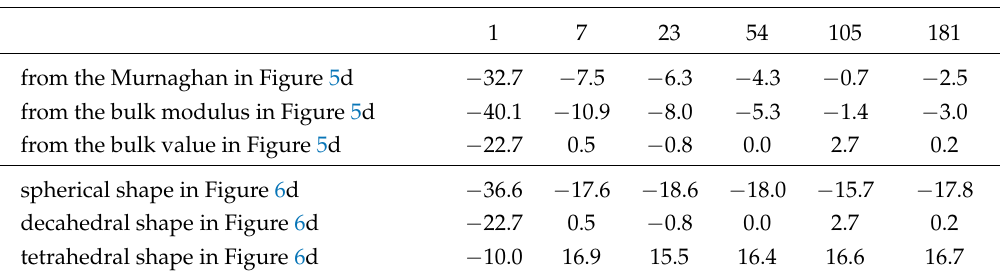
Table 3. Relative differences (Equation (14)) of the excess energy per atom (Equation (13)) shown in Figures 5 and 6. D [%] of the Excess Energy E ex Per Atom Number of Atoms in the Nanocluster/Nanoparticle from the Murnaghan in Figure 5d from the bulk modulus in Figure 5d from the bulk value in Figure 5d spherical shape in Figure 6d decahedral shape in Figure 6d tetrahedral shape in Figure 6d